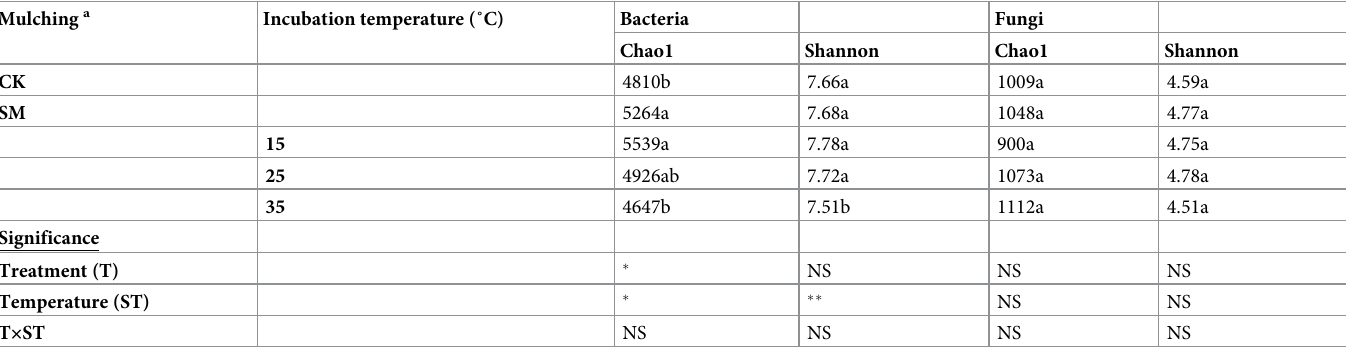
Table 5. Soil bacterial and fungal diversity (Shannon index) and richness (Chao1 index) under different mulching methods after incubation. Mulching